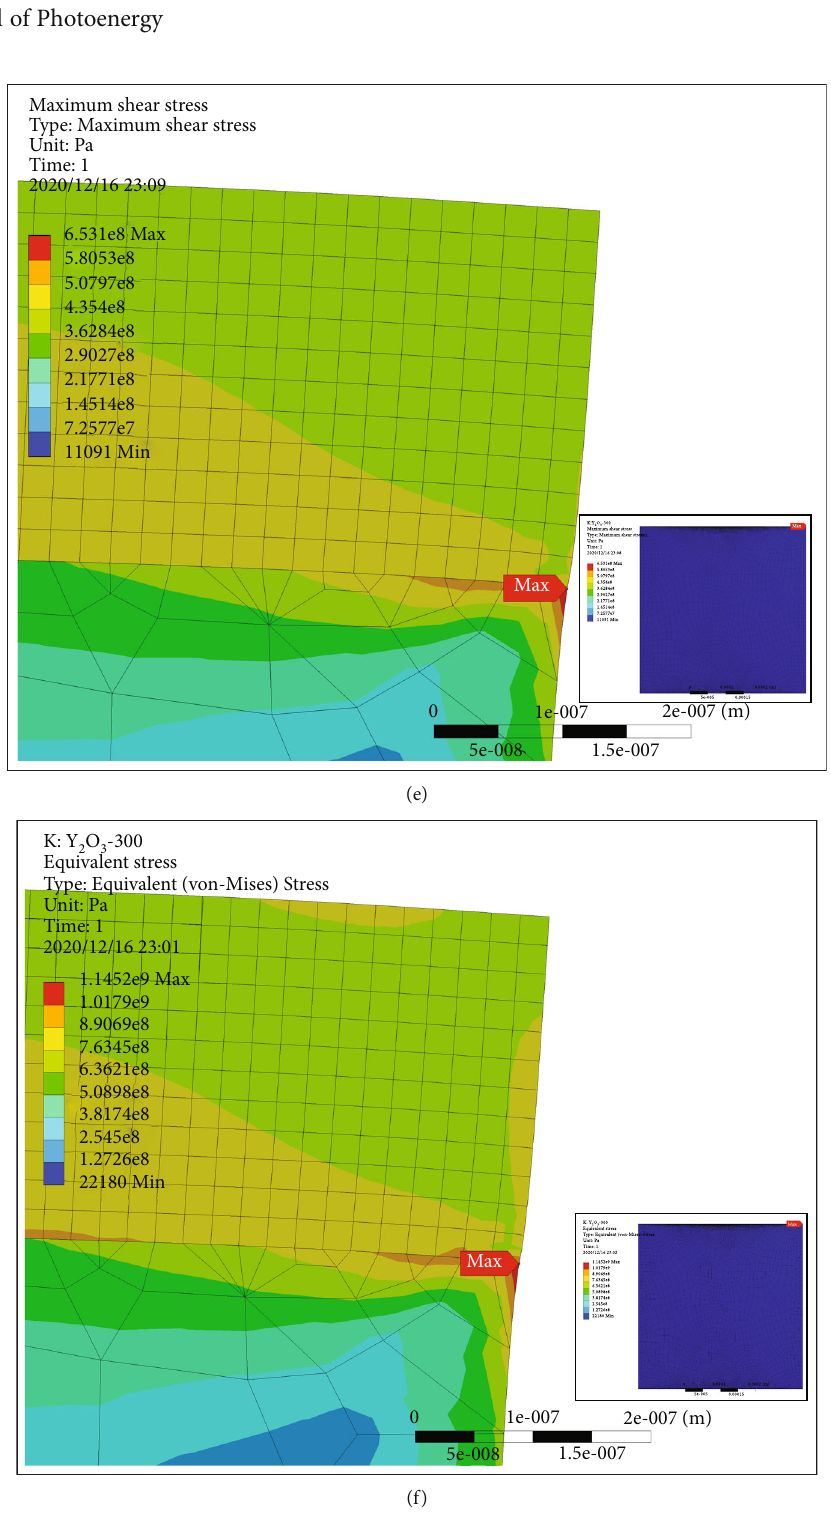
Figure 5: Comparison of 3 kinds of stress distribution: (a) max principal stress (Al (c) max Mises stress (Al O , t = 300 nm stress (Y 2 3